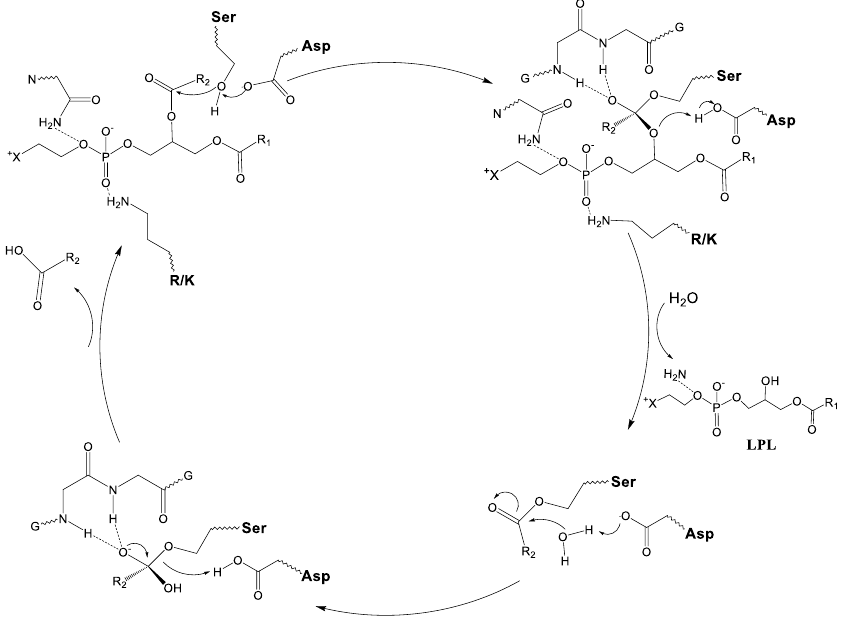
Figure 14. The proposed common mechanism of cPLA2 and iPLA2 for hydrolysis of phospholipids. The two classes of PLA2s share a common Ser/Asp dyad.